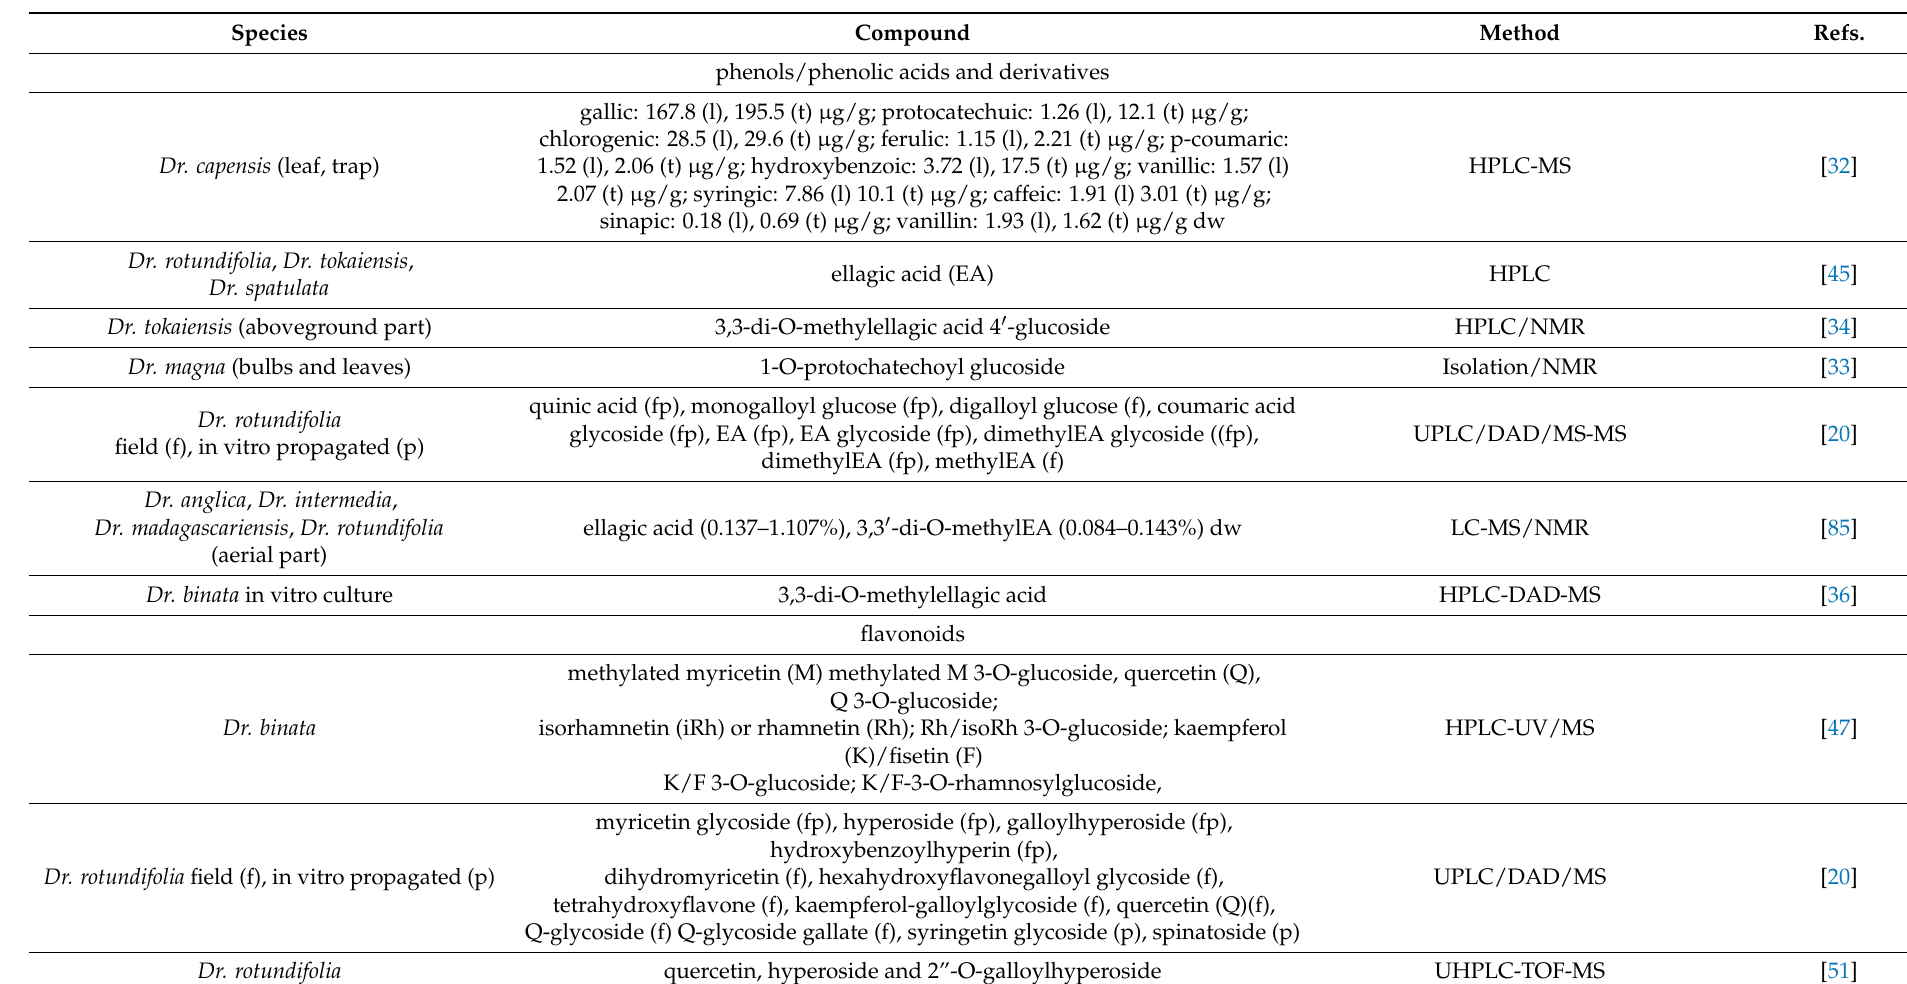
Table 2. Secondary metabolites identified in